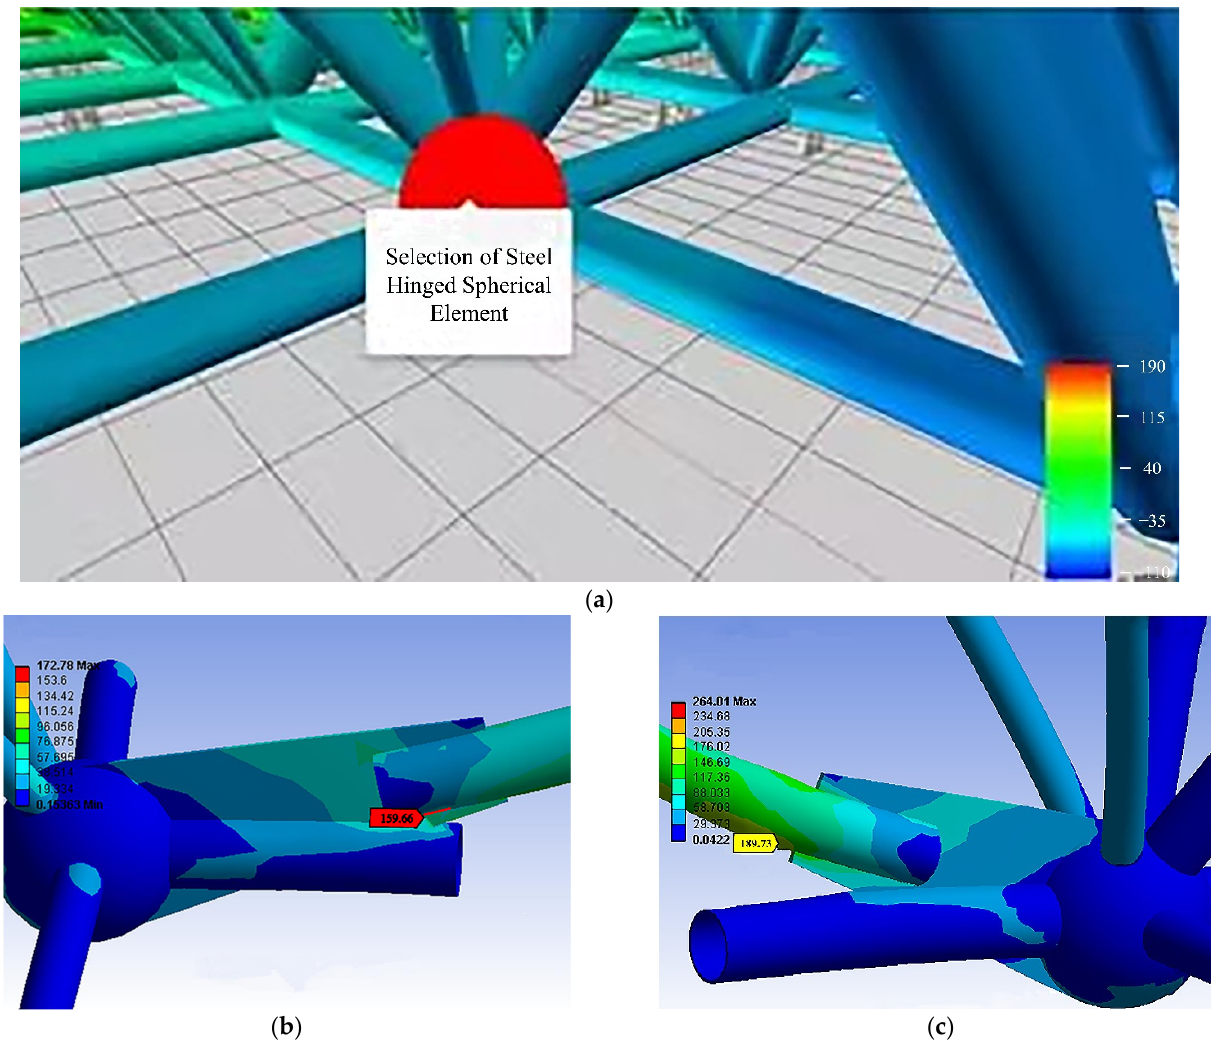
Figure 12. ( a ) Schematic diagram for the selection of the steel hinged spherical element; ( b ) stress inspection of member 17; ( c ) stress inspection of member 20.